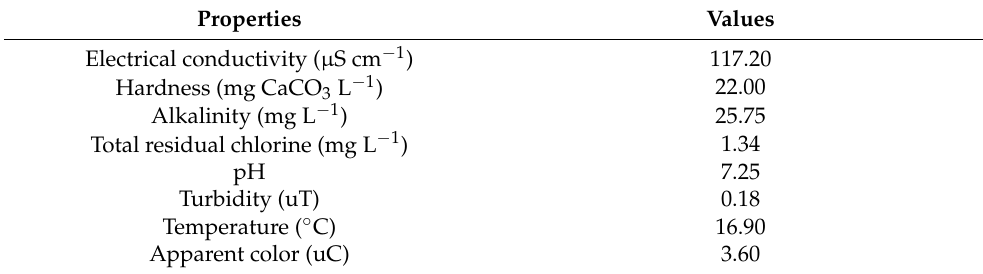
Table 1. Selected drinking water quality properties.